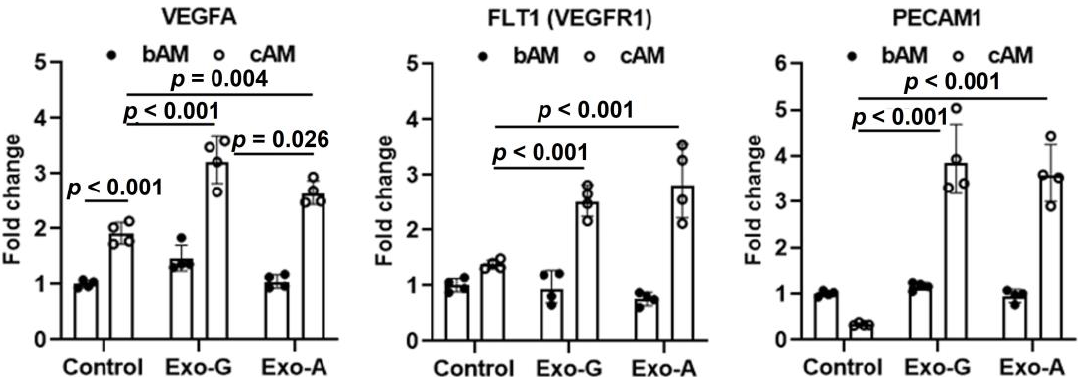
Figure 3. The effect dental pulp stem cells-derived exosomes (DPSC-Exos) on angiogenic differentiation. Exosomes (5 × 10 8 /mL) isolated from DPSCs cultured under a growth (Exo-G) or angiogenic differentiation condition (Exo-A) were treated in either basal or complete angiogenic induction medium (bAM or cAM) ( n = 4). Control: no exosome treatment. VEGFA: vascular endothelial growth factor A, FLT1: Fms-related tyrosine kinase 1 (known as VEGF receptor 1), and PECAM1: platelet and endothelial cell adhesion molecule 1.